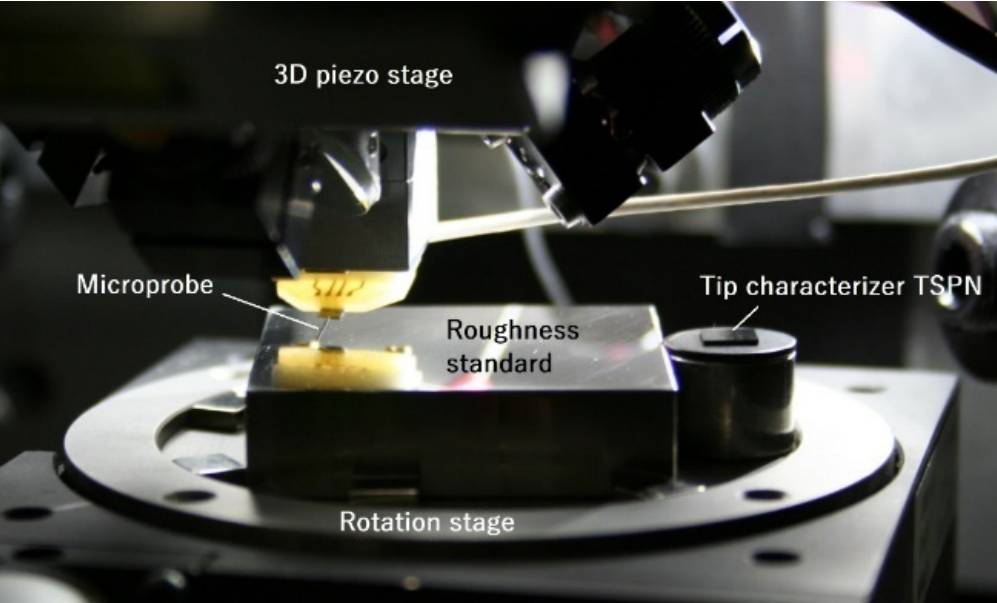
Figure 8. Experimental setup to investigate tip geometry variation during roughness measurements. Steel roughness standards with arithmetical mean deviation Ra values from 0.02 µm